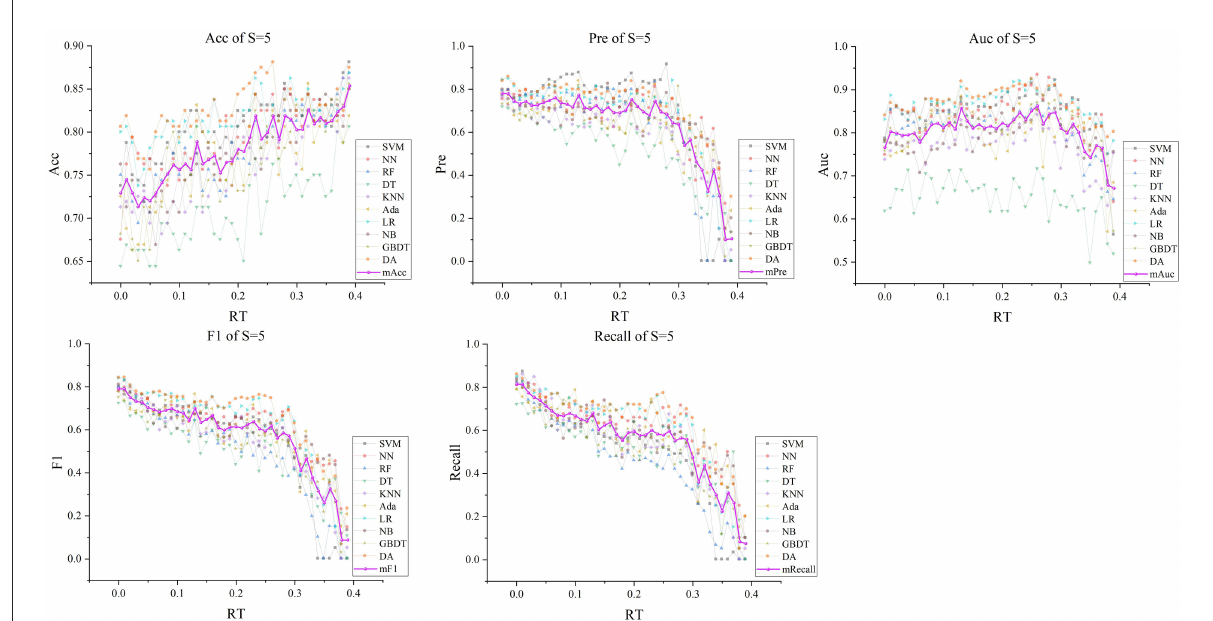
FIGURE8 The five indexes of F ′ RT_S with S = 5 on the ten models, wherein the dark purple lines represent the mean indexes (mAcc, mPre, mAuc, mF1, mRecall), and the other colors represent the performance of the ten models.